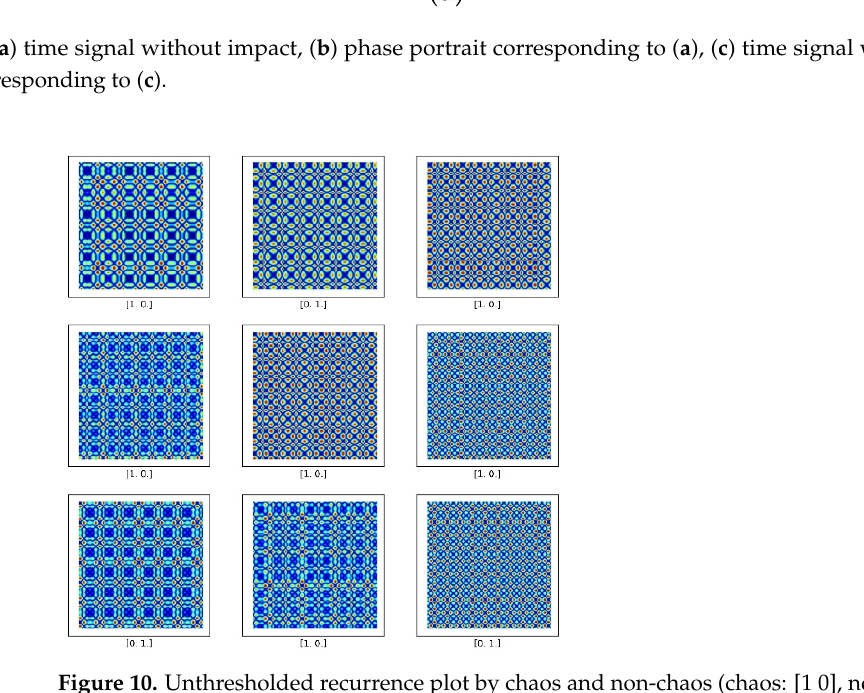
Figure 11. Unthresholded recurrence plot by chaos and non-chaos (chaos: [1 0], non-chaos: [0 1]). 4. Discussions This study developed a CNN model that visualizes a dynamic signal with high order nonlinearity and distinguishes between chaos and non-chaos. In addition, the chaotic characteristics were verified by calculating the Lyapunov exponent. The signal generated in the dynamic system could be distinguished from the chaotic characteristics by calculating the Lyapunov exponent. On the other hand, the actual signals were complexly generated with noise and uncertainty. Visualization of the dynamic signals was used as a general method of analyzing the signal characteristics, but signals with nonlinearity are very difficult for engineers to analyze. In particular, chaotic signals cannot be classified accurately by the human cognitive ability, and theoretical analysis methods have limitations. CNN models have been developed that overcome the errors in human cognitive ability owing to the rapid development of artificial intelligence. Therefore, a simple CNN model that distinguishes between chaos and non-chaos with an accuracy of approximately 95% was developed. A new methodology that can analyze a real complex signal and more complex signals, such as BSR noise, will be discussed in the future. In the future, this method of obtaining the feature learned from explicitly known equations and the Lyapunov exponent will be further applied to the experimental signal from which the Lyapunov exponent is not clearly calculated. ( a )